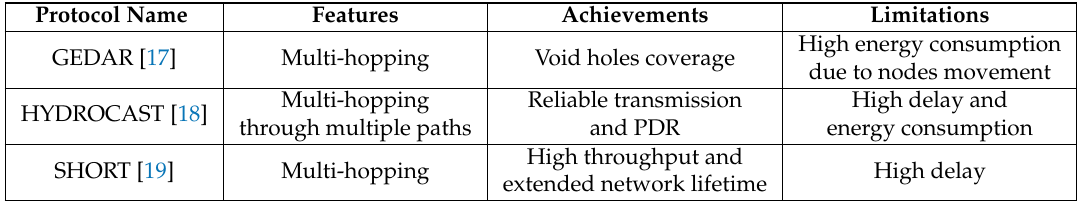
Table 3. Comparison of Void Avoidance Routing